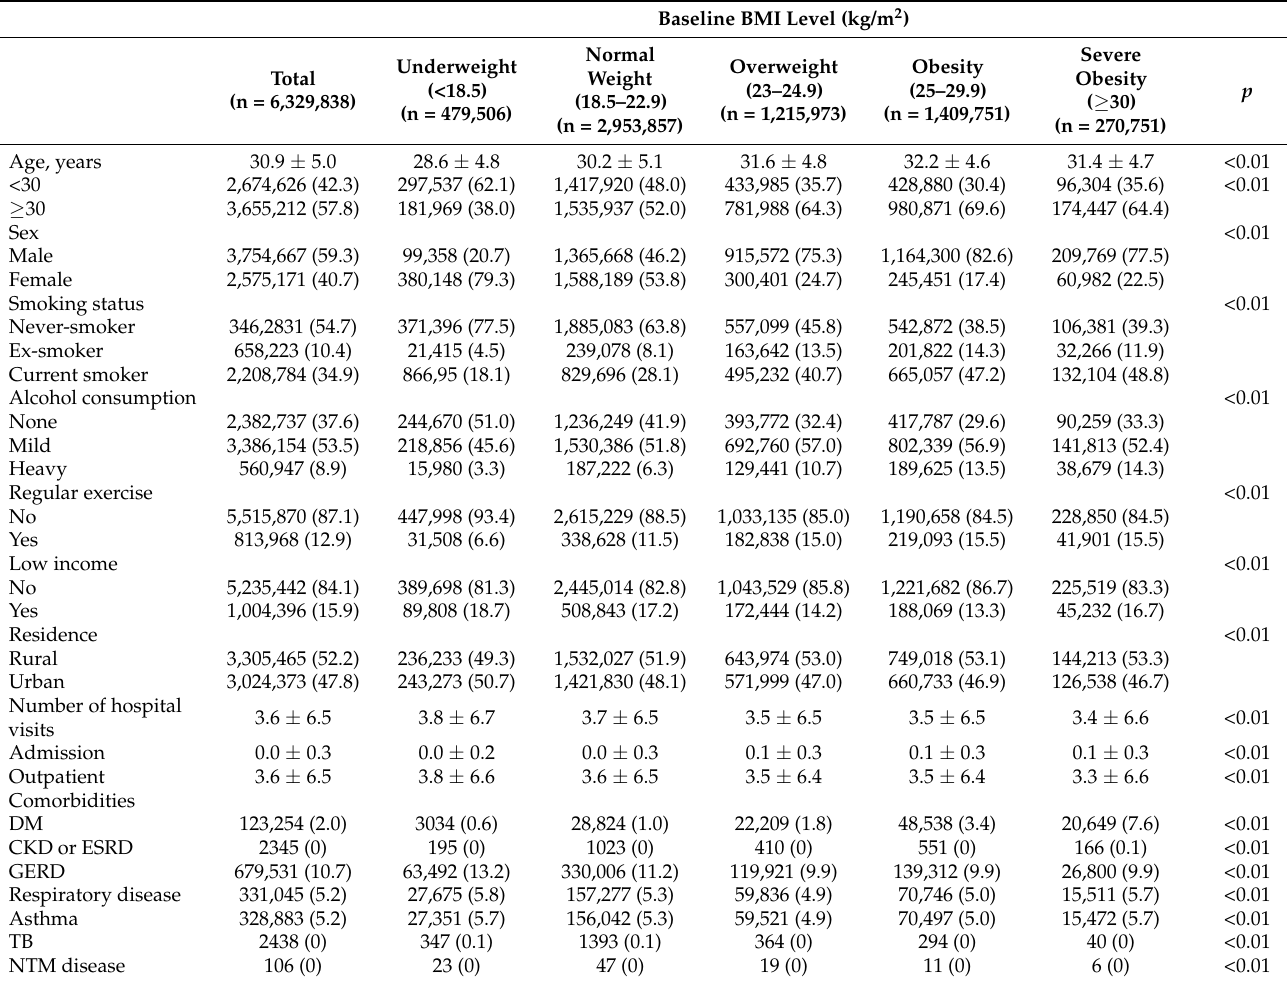
Table 1. Baseline characteristics of the study population according to body mass